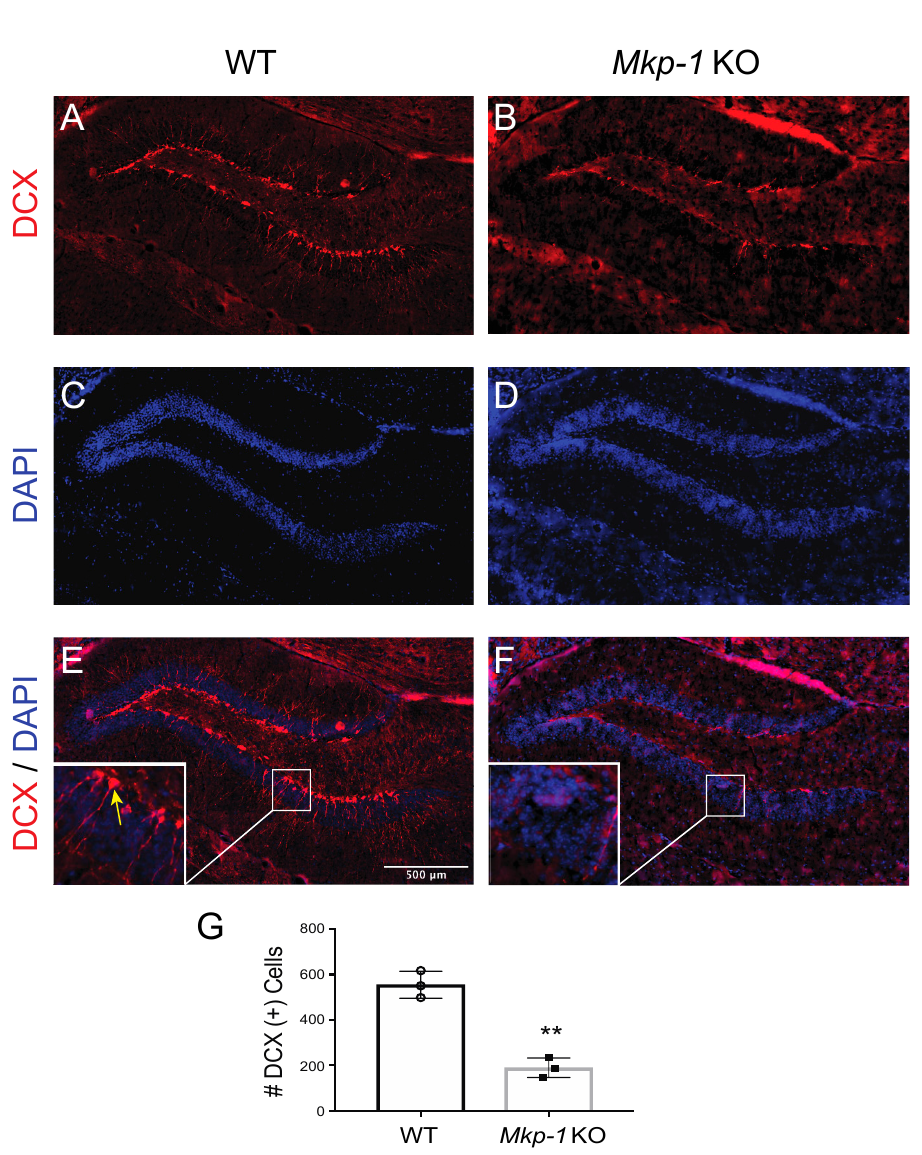
Figure 1. Mkp-1 KO mice exhibit fewer DCX positive neurons in the dentate gyrus (DG). ( A , B ) Im- munofluorescence images of the dentate gyrus in wild-type (WT) and Mkp-1 KO mice stained with doublecortin (DCX). ( C , D ) DAPI nuclear counterstain of the dentate gyrus. ( E , F ) Composite images with high-power view illustrating individual DCX+ cells (yellow arrow). ( G ) Results of DCX+ cell counts in WT and Mkp-1 KO cultures ( n = 3, t -test, ** p < 0.01).